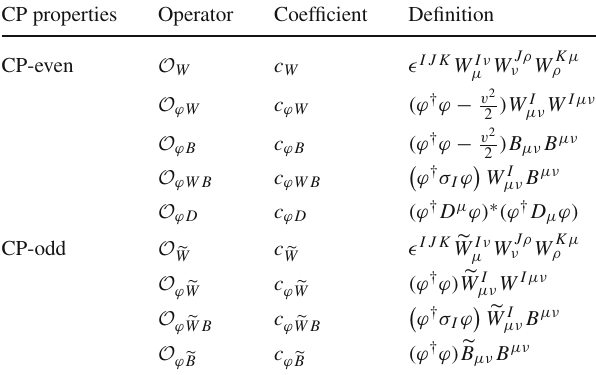
Table 2 Dimension-six operators that modify the interactions of the electroweak gauge bosons and that are composed by two fermion fields, two Higgs fields, and one covariant derivative. The sum over the index j runs over the three SM generations, which are treated symmetrically in this